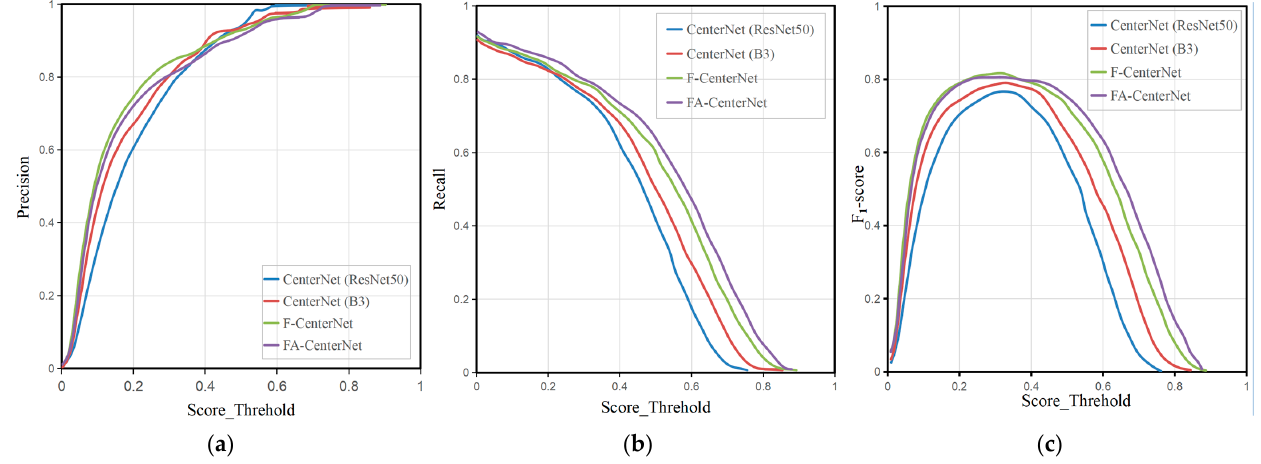
Figure 8. Impact of Score thresholds. ( a ) Precision vary with the score threshold. ( b ) Recall vary with the score threshold. ( c ) F 1 - scores vary with the score threshold.